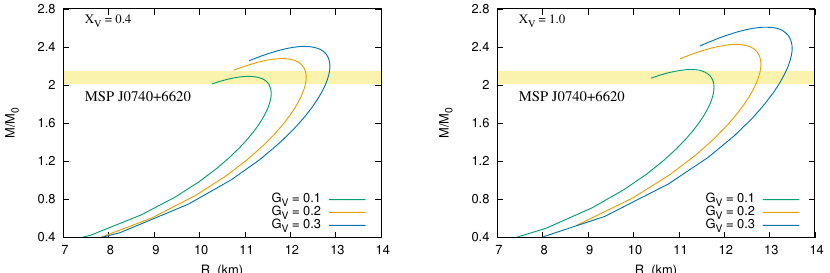
Figure 22. Mass–radius diagram obtained with the minimum value of the bag pressure that produces stable quark stars with different values of G v and left) X v = 0.4, right) X v = 1.0. Figure based on the results presented in